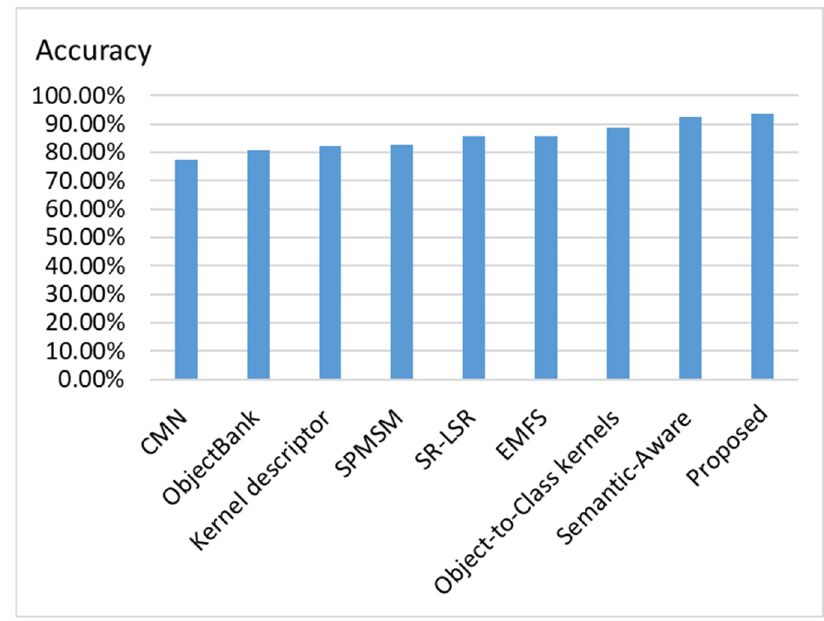
Figure 8. Comparisons of existing scene classification methods on 15-Scene dataset.